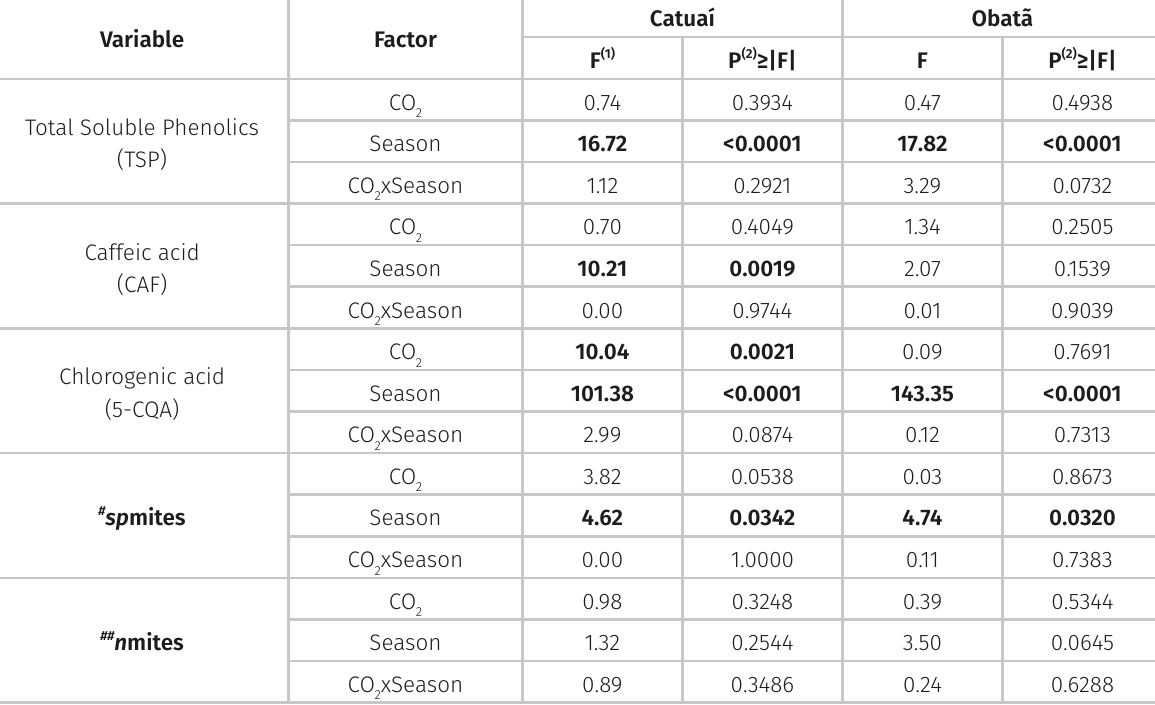
Table I. Variance analysis of TSP, CAF, 5-CQA, mite diversity ( sp mites) and mite population ( n mites), in two coffee cultivars (Catuaí and Obatã), with two levels of [CO arrange.